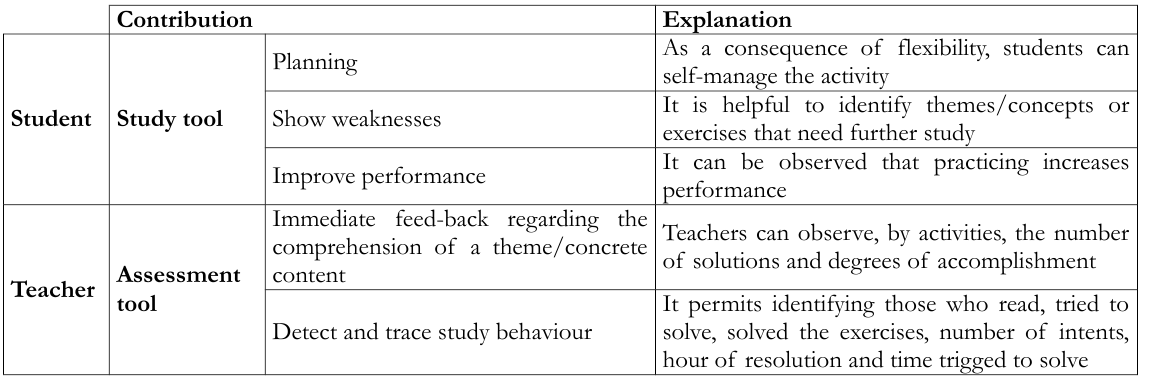
Table 6. The automatic spreadsheet corrector‘s contribution to